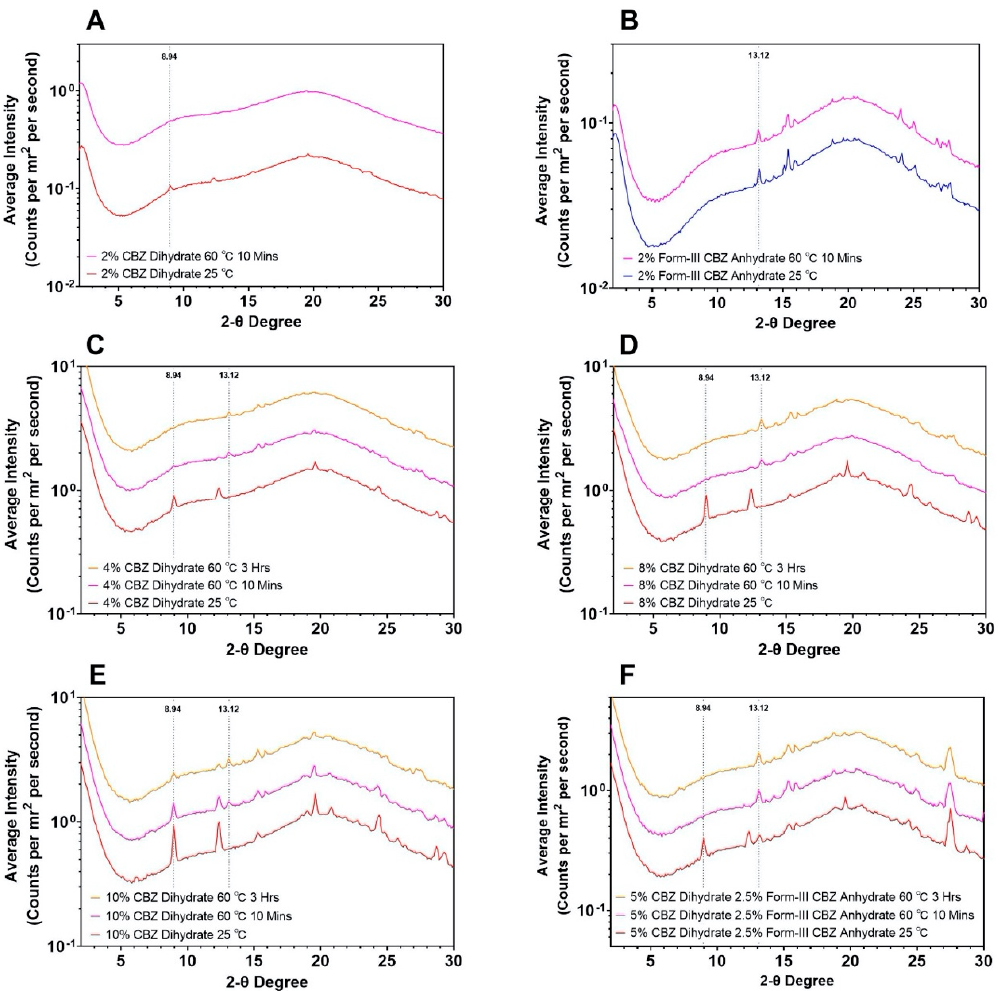
Figure 10. WAXS patterns of CBZ dihydrate and form-III CBZ anhydrate at various experimental conditions. A . 2% CBZ dihydrate; B . 2% form-III CBZ anhydrate; C . 4% CBZ dihydrate; D . 8% CBZ dihydrate; E . 10% CBZ dihydrate; and F . 5% CBZ dihydrate with 2.5% form-III CBZ anhydrate.